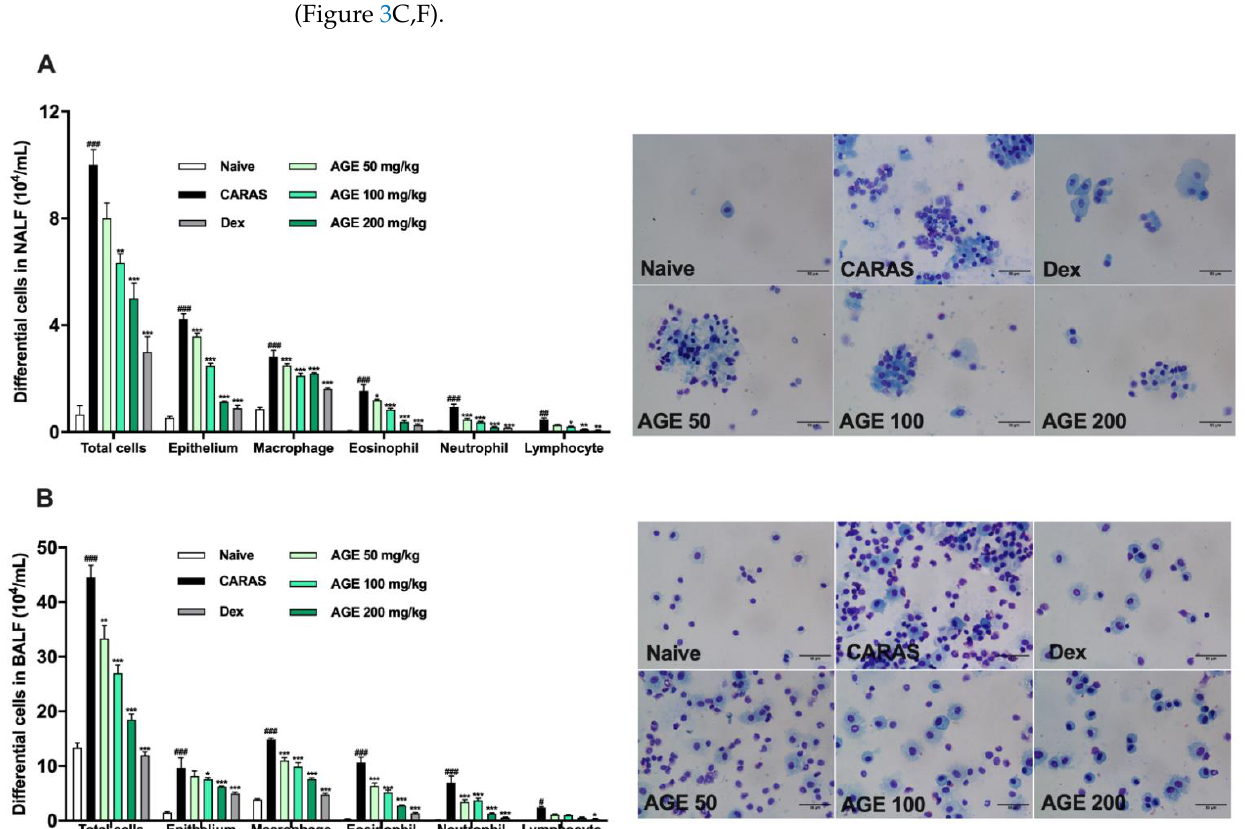
Figure 2. AGE suppressed the infiltration of differential inflammatory cells in both NALF and BALF of CARAS mice. ( A ) Differential inflammatory cells in NALF. ( B ) Differential inflammatory cells in BALF. The number of epithelial cells and inflammatory cells (eosinophil, neutrophil, and macrophage) were majorly increased in both NALF and BALF of the CARAS group compared with the naive group, and those cells numbers were significantly decreased by AGE 50, 100, 200 mg/kg, and Dex 2.5 mg/kg. All results are shown as the mean ± SD (n = 6 per group). # Compared to naive, * compared to CARAS. ### , *** p < 0.001; ## , ** p < 0.01, * p < 0.05. CARAS = combined allergic rhinitis and asthma syndrome; AGE = Artemisia gmelinii extracts; Dex = dexamethasone; BALF = bronchoalveolar lavage fluid. Scale bar = 50 µm.